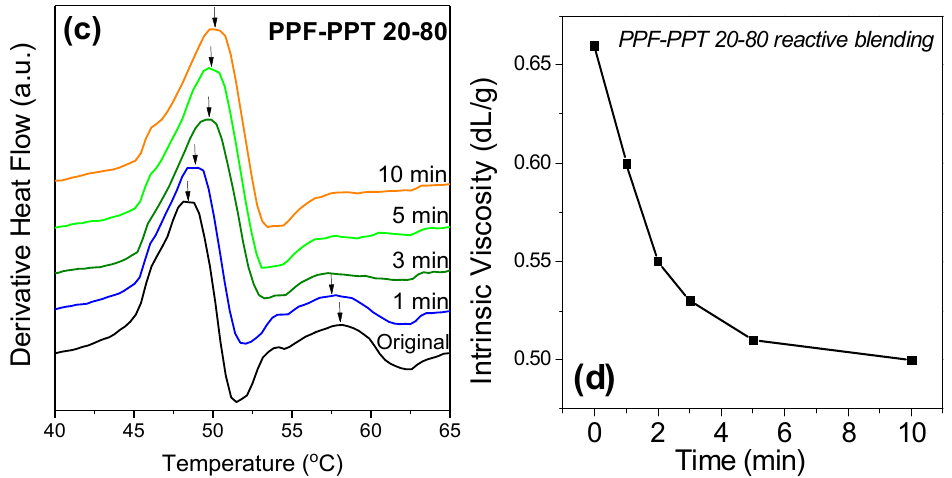
Figure 9. ( a ) Effect of the time of reactive blending on the DSC thermograms of the PPF–PPT 20–80 sample, ( b ) zoomed-in area of the glass temperature for the PPF–PPT sample prepared under different reactive blending times, ( c ) derivative of heat flow, and ( d ) variation of the intrinsic viscosity with reactive blending time.